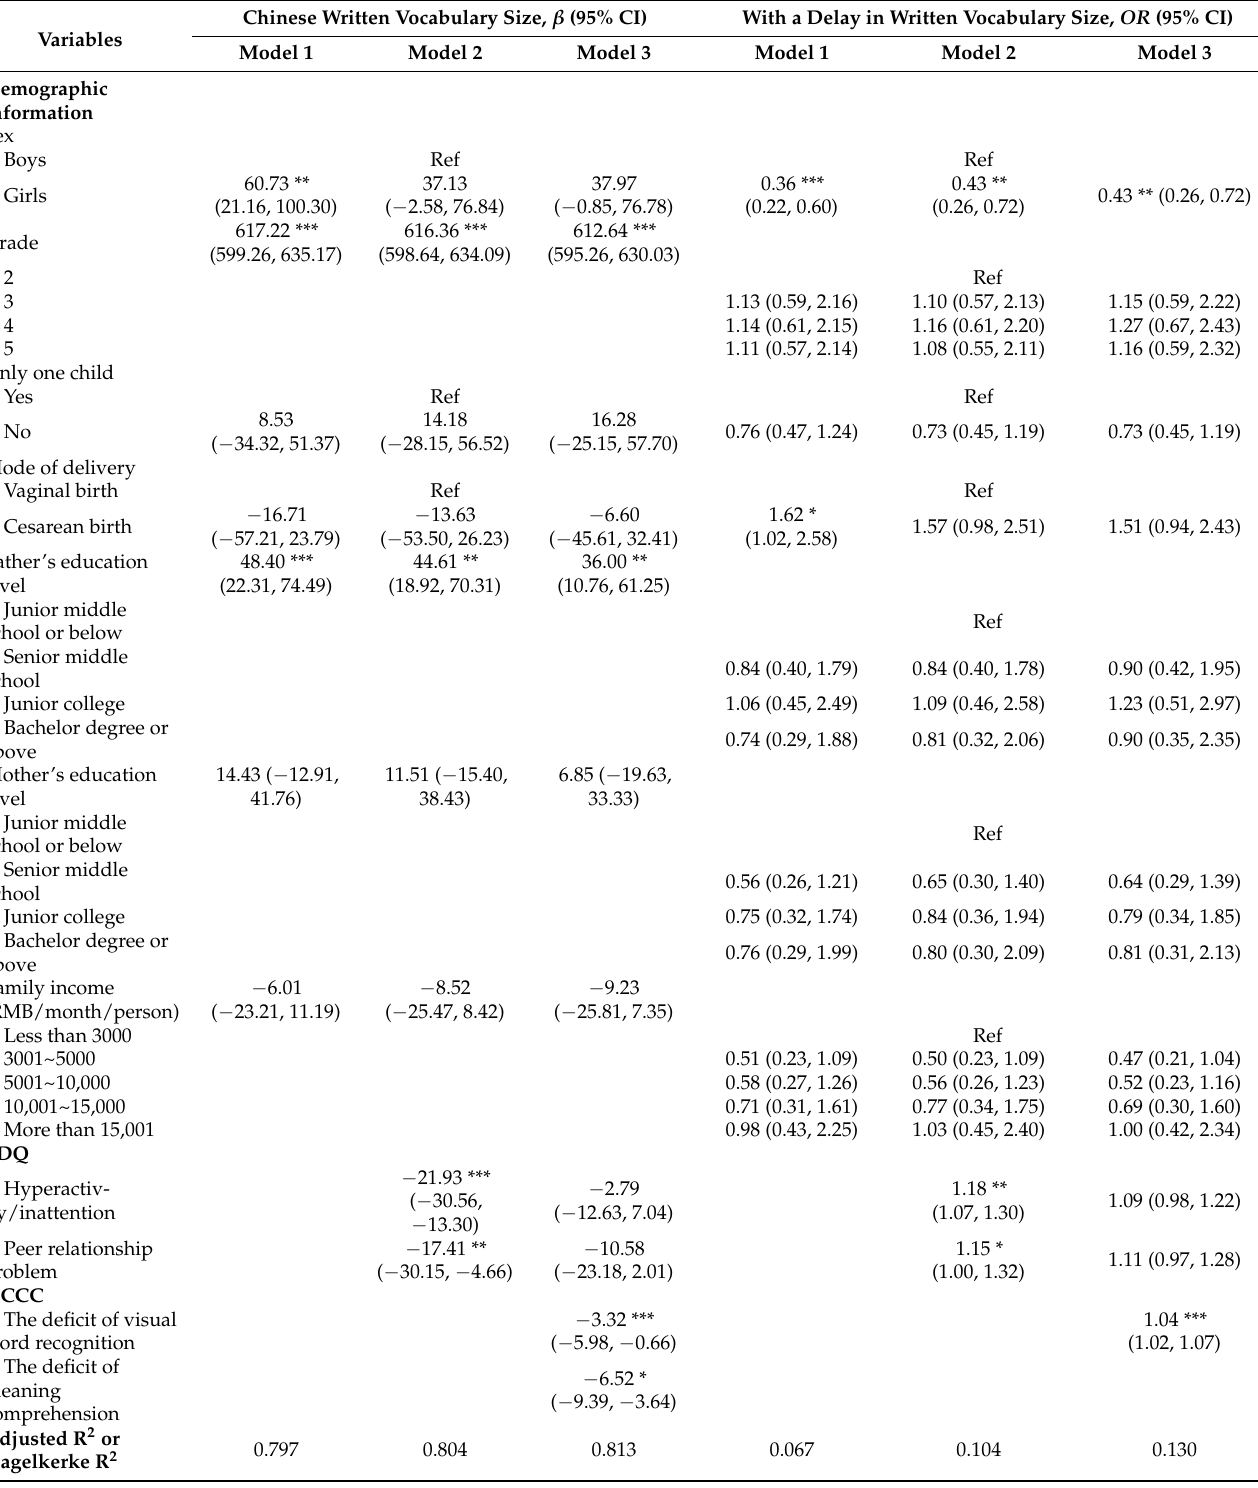
Table 3. Multiple stepwise linear and logistic regression analysis for related factors of Chinese written vocabulary size (N =